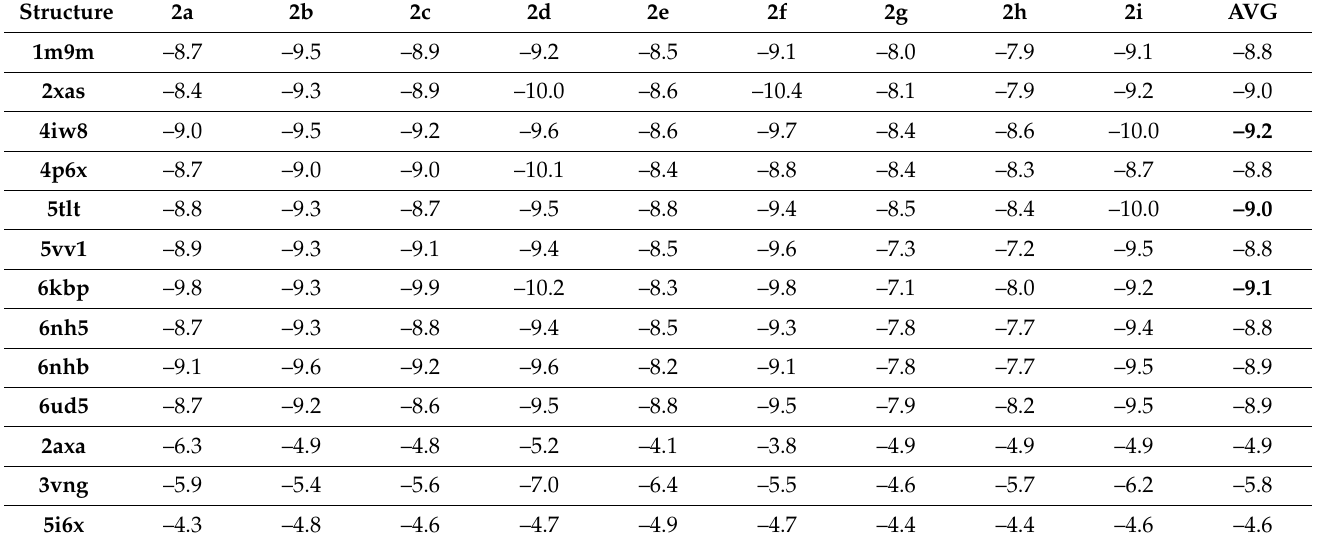
Table 3. The energy of interaction of 13 predicted protein–ligand pairs in kcal/mol (10 was the most favorable and 3 was the least favorable). The results for other 156 structures could be found in supporting information. PDB entries obtained from